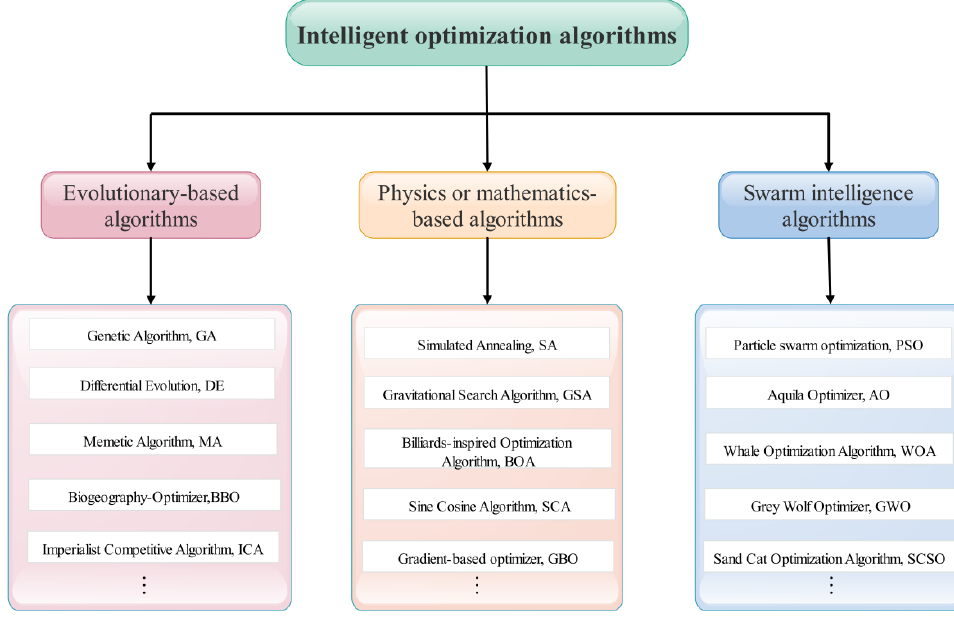
Figure 1. The classification of intelligent optimization algorithms.